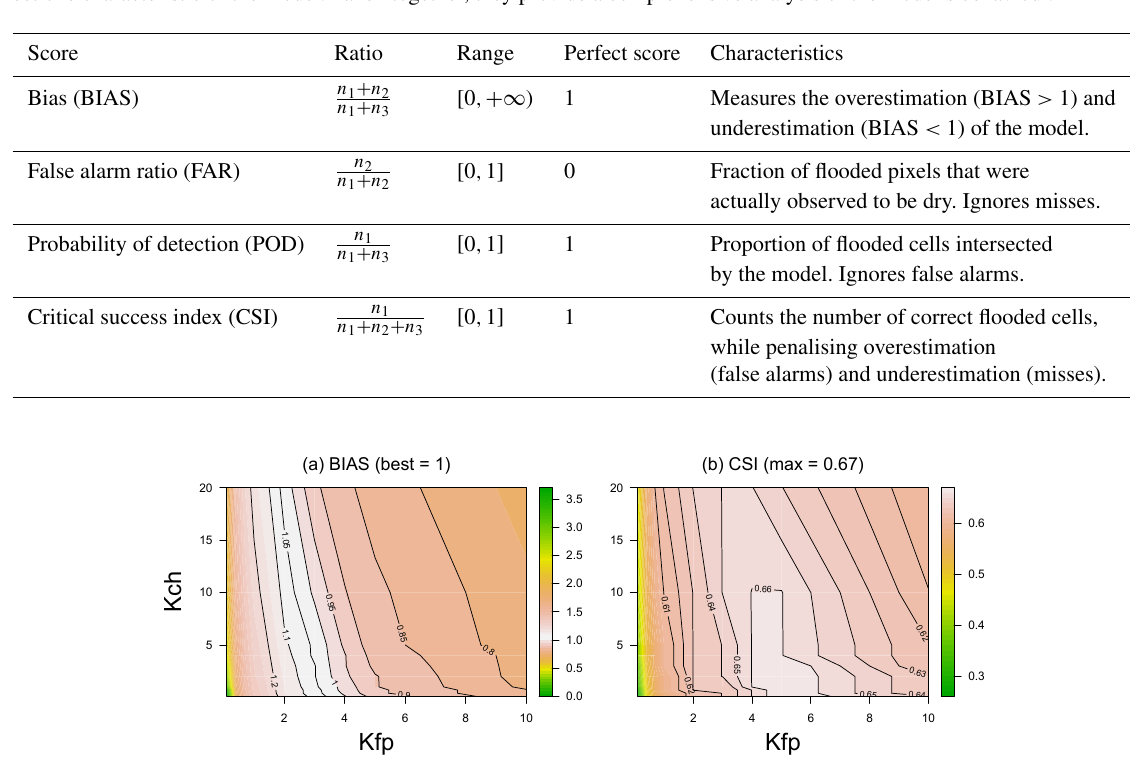
Figure 9. Forecast scores obtained by the model on the River Loing versus Copernicus data for all the parameter values tested, (a) BIAS contour lines and (b) CSI contour lines for various values of K ch and K fp